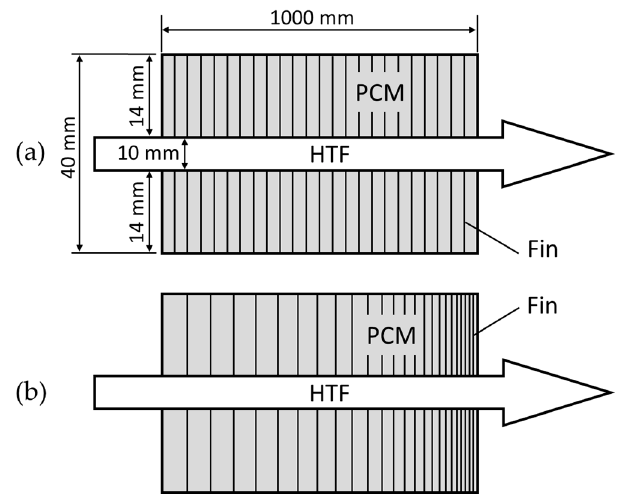
Figure 2. Single storage element with ( a ) homogeneous; and ( b ) uneven distribution of circular fins.